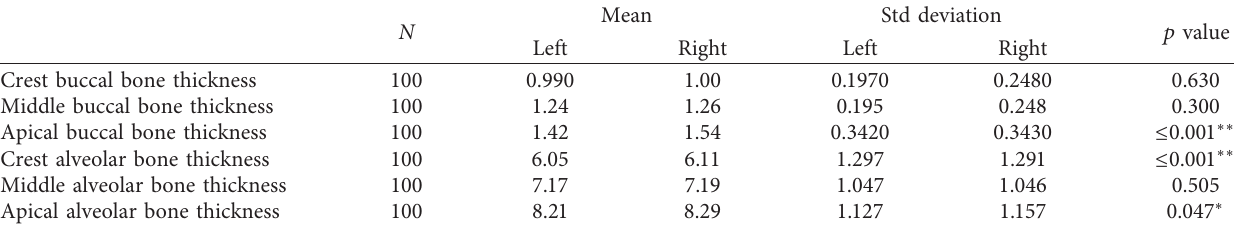
Table 5: Descriptive statistics of bone thickness (mm) by side and comparison of left and right thickness according to site.